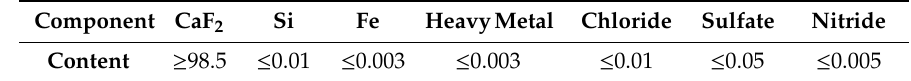
Table 3. The composition of the coking coal (wt %).